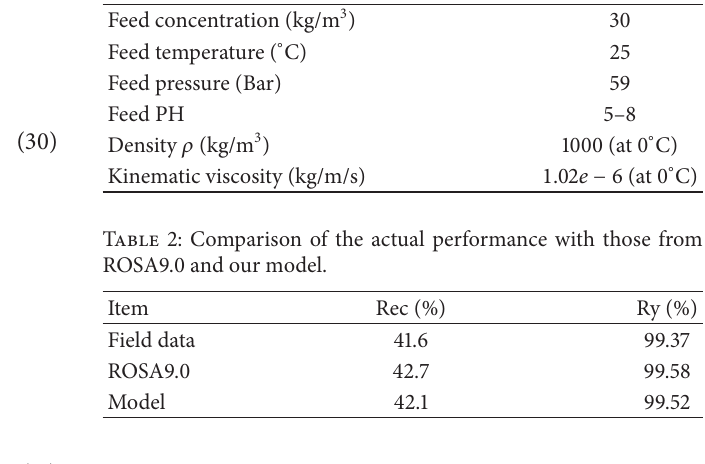
Table 1: Feed condition of the seawater plant.